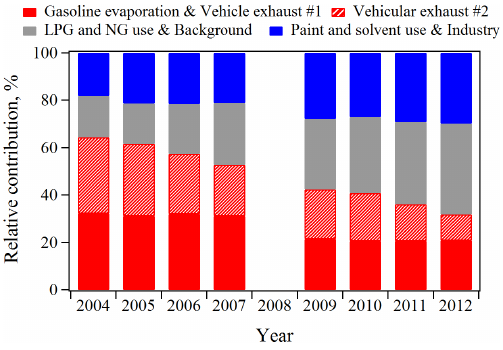
Figure 10. Relative contributions of four PMF-resolved factors to ambient concentrations of NMHCs (µgm − 3 ) measured at the PKU site during August from 2004 to 2012. Owing to the influence of the short-term control measures for the Beijing Olympic Games during August 2008, relative contributions of these four PMF-resolved fac- tors were not shown in this figure.